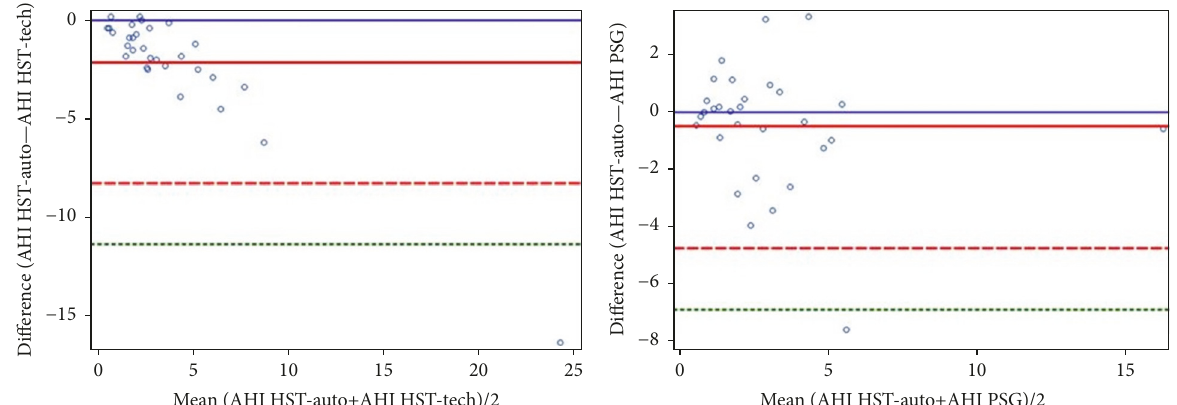
(b) Bland-Altman Plot of Difference (HST-auto—PSG) versus Mean.